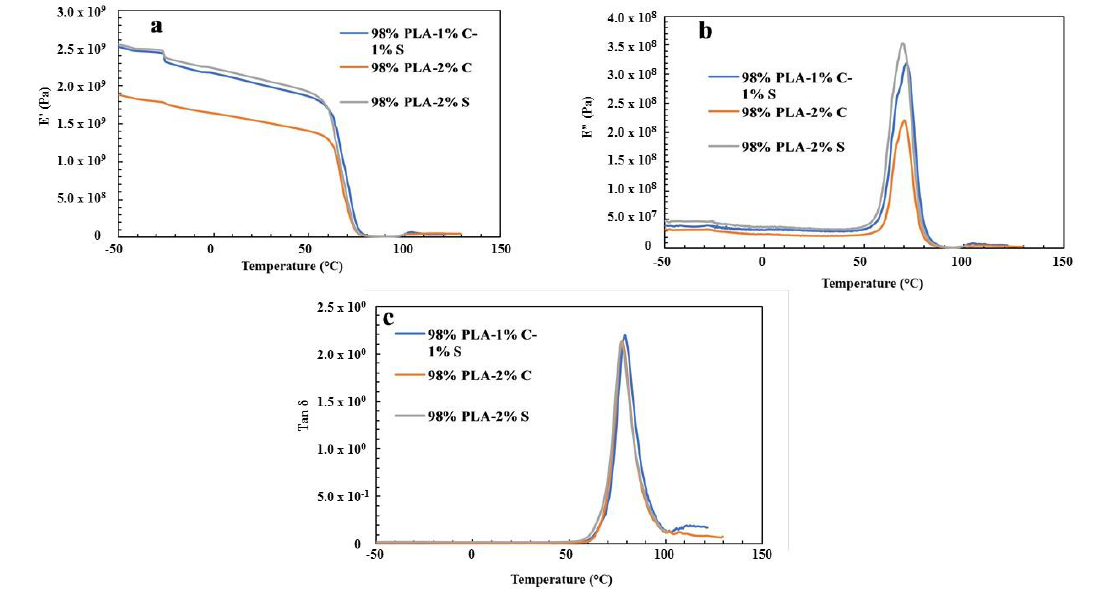
Figure 5. ( a ) Storage modulus (E’); ( b ) loss modulus (E”); ( c ) loss factor tan δ for 98% PLA–1%